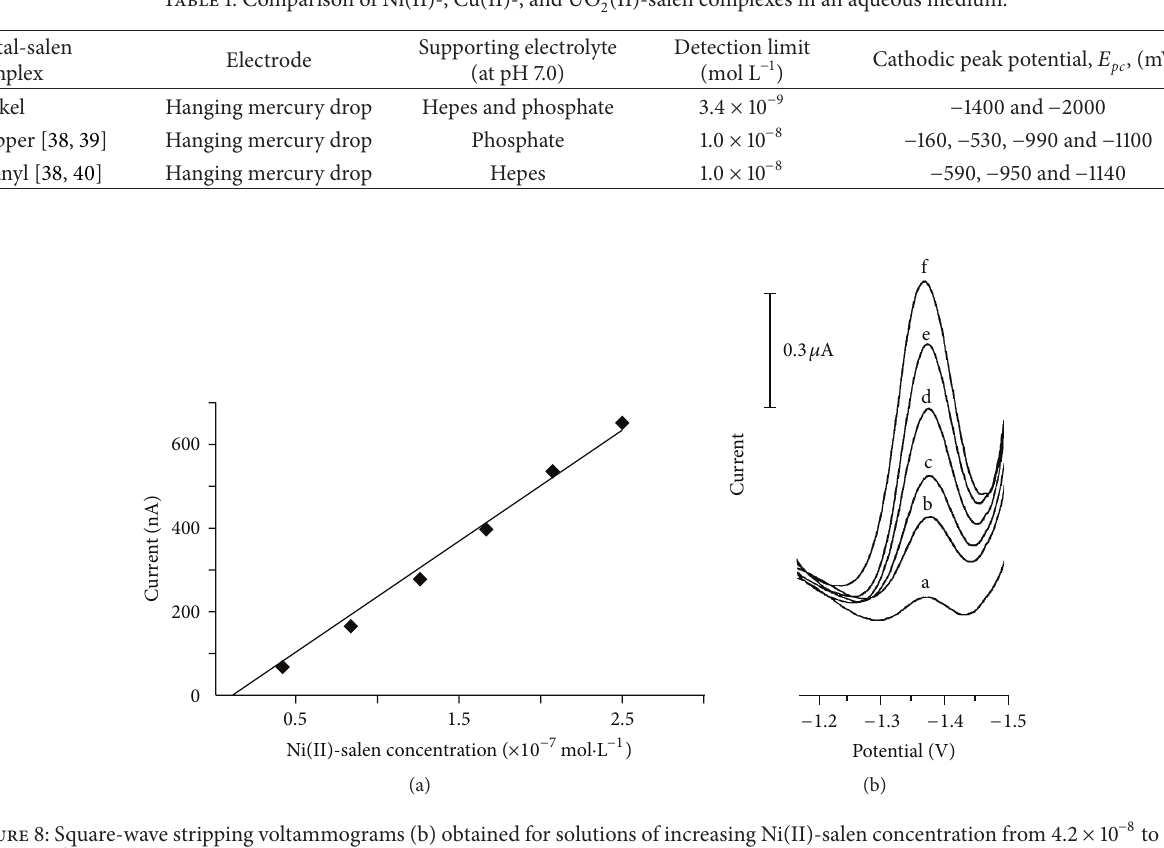
Table 1: Comparison of Ni(II)-, Cu(II)-, and UO